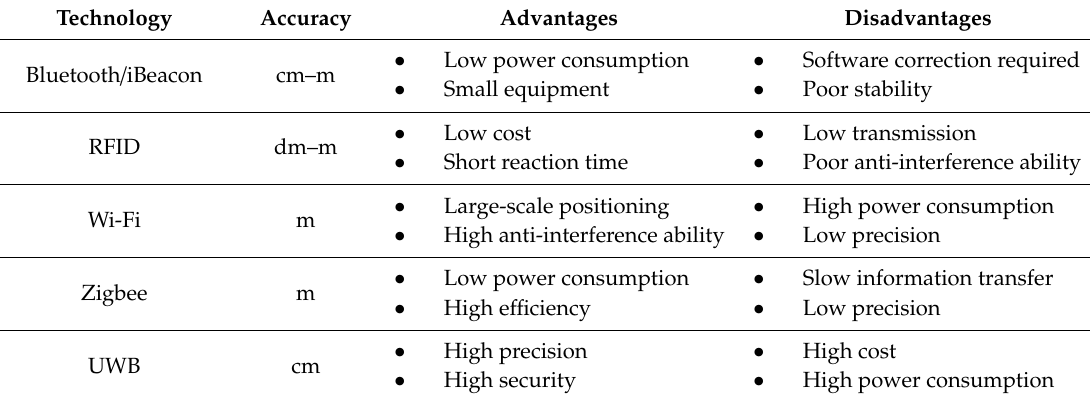
Table 2. Comparison more frequent use of Wireless Indoor